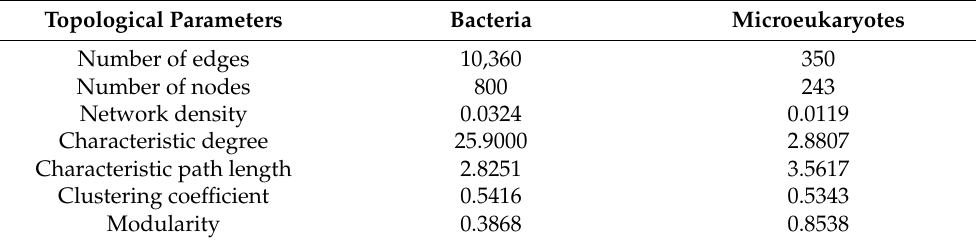
Table 1. The key topological features of aquatic microbial networks.